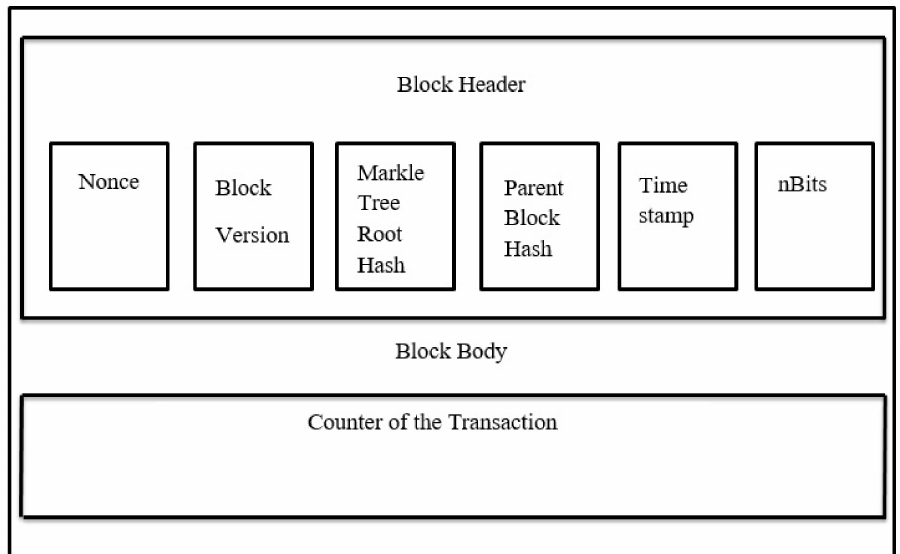
Figure 2. Block structure.